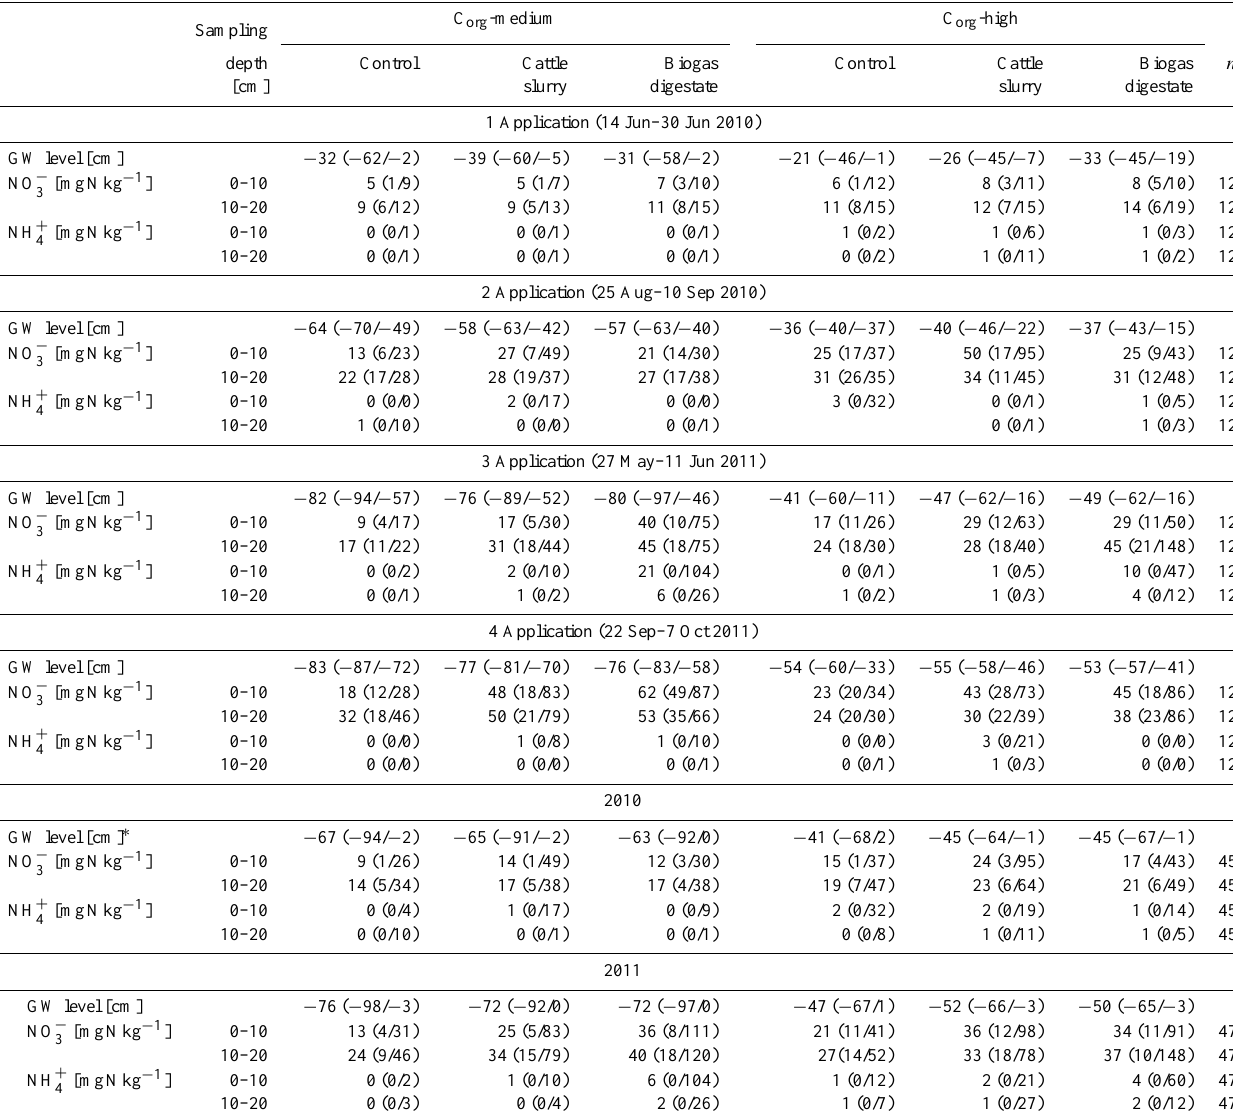
Table 4. Mean (minimum/maximum) groundwater level (GW), NO − and for the investigated years 2010 and